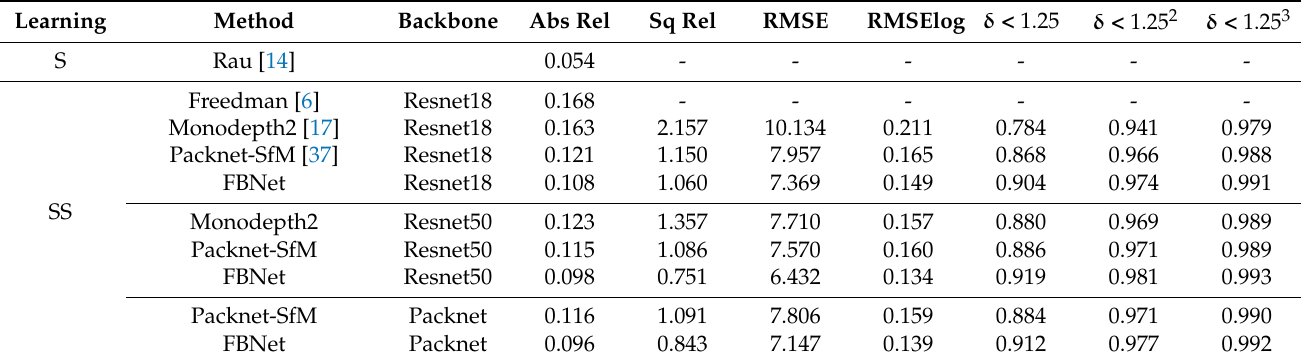
Table 1. Quantitative performance comparison of the proposed algorithm on the UCL datasets. In the learning column, S refers supervised learning and SS refers self-supervised learning. For Abs Rel, Sq Rel, RMSE, and RMSElog lower is better, δ < 1.25, δ < 1.25 2 , δ < 1.25 3 higher is better. The best performance of the test for each backbone is indicated in bold, and the best performance of all experiments is indicated by an